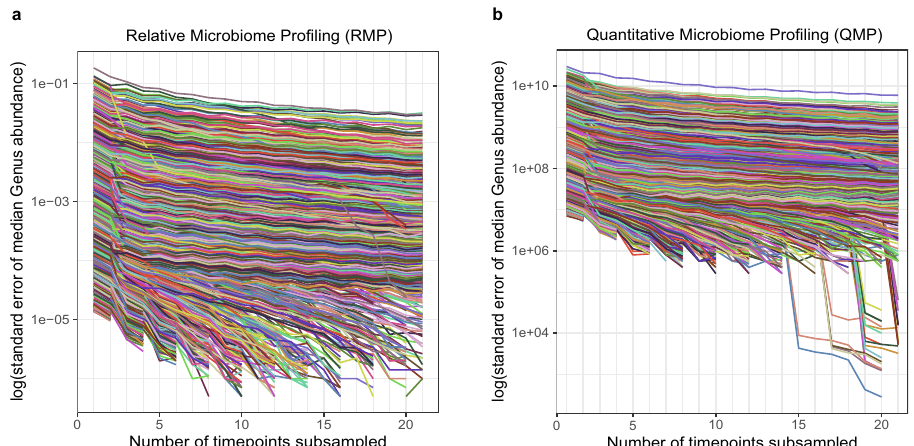
Fig. 3 Gains in accuracy in the estimation of the equilibrium abundance are highest for the fi rst fi ve samples for both RMP and QMP. The availability of multiple timepoints allows improved estimation of the equilibrium genus abundance through summary measures (e.g., median). However, gains in accuracy decrease with additional timepoints. We calculated the error on the median genus abundances ( y -axis) depending on the number of timepoints (100 most abundant genera, all participants, timepoints randomly chosen out of the full time series, 10.000 iterations). The elbow of the curve, a point that signi fi es an optimum in the trade-off between accuracy and sampling effort, lies roughly around 5 samples for both RMP ( a ) and QMP ( b ). Gains in accuracy level off afterwards as evidenced by the fl atter curves.